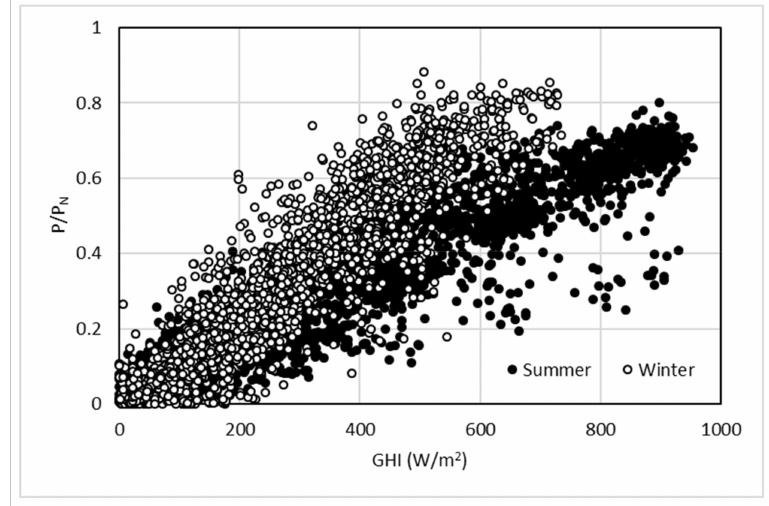
Figure 8. Comparison of the PV system performance curves between summer and winter (Jeollabuk-do Gochang-gun, 500